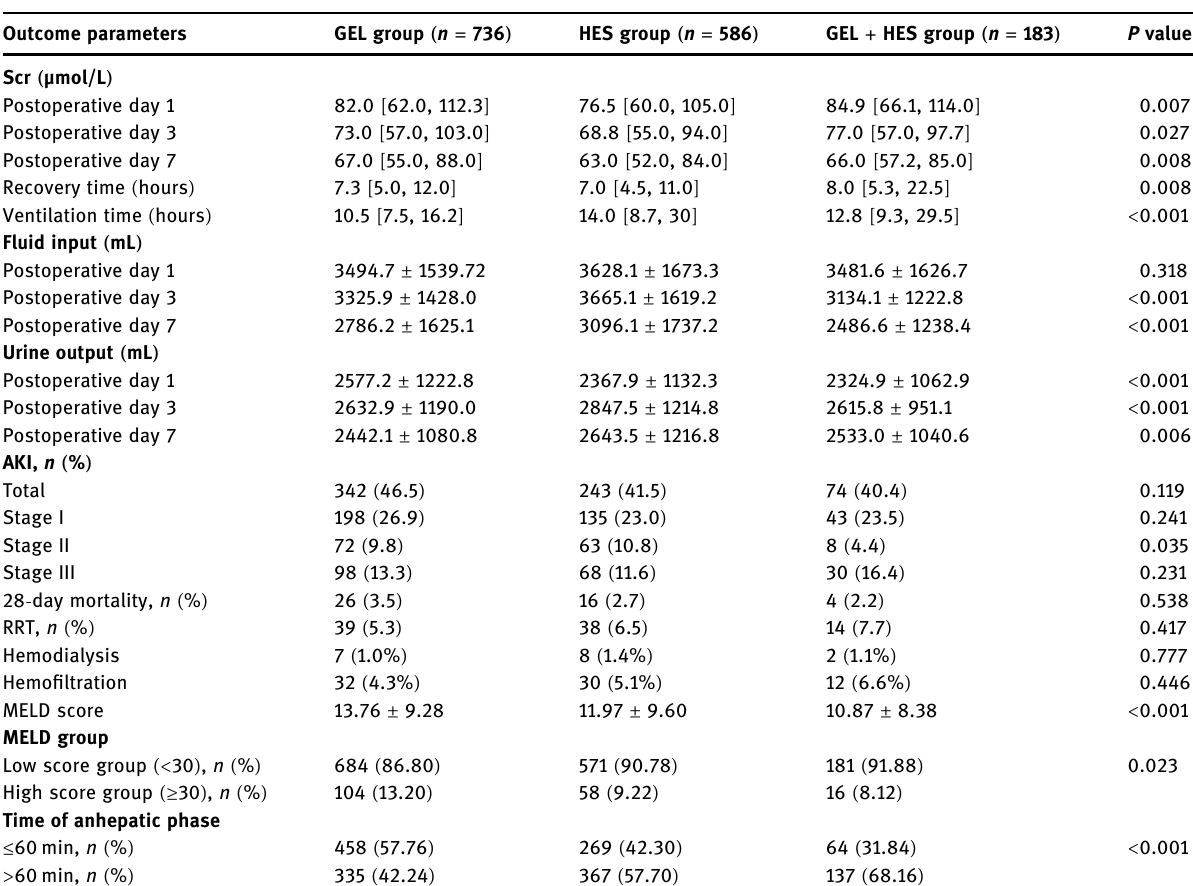
Table 2: Postoperative outcomes Outcome